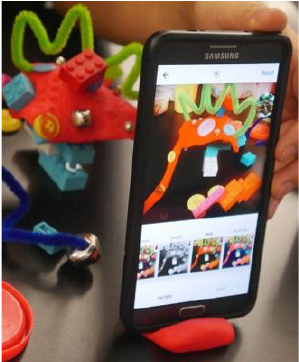
Figure 3. The remix creature (source: created by